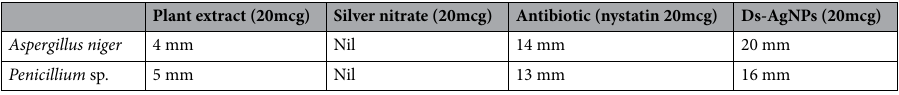
Table 3. Antifungal activity of Ds-AgNPs on Aspergillus niger and Penicillium sp.